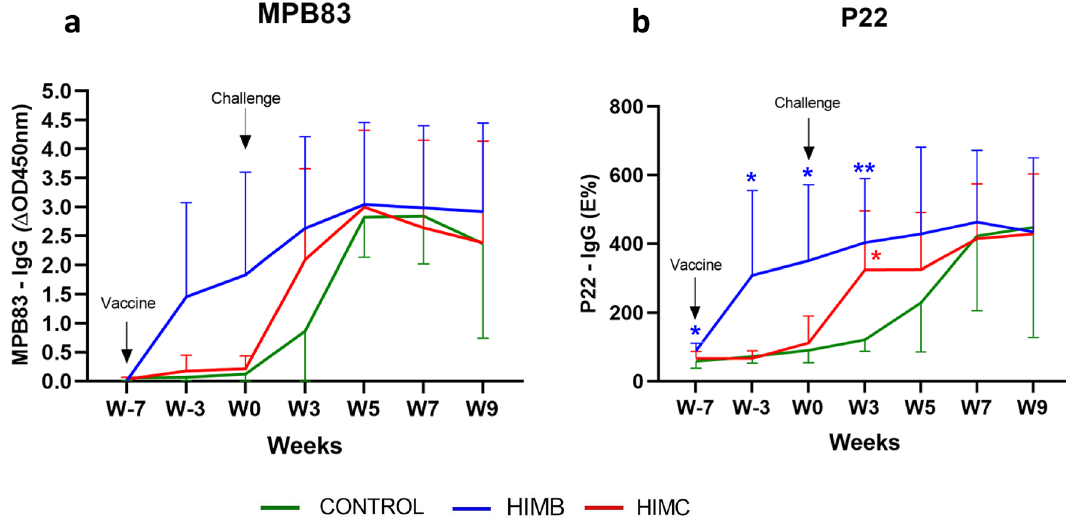
Figure 4. Antibody responses after vaccination and challenge. The figure shows the levels of IgG against MPB83 and P22 antigen measured by ELISA throughout the study. MPB83 results are expressed as the increase of optical density (ΔOD450mn ± 95% CI). P22 ELISA results are expressed as E%: [mean OD450nm of antigen- coated well/(2 × mean negative control OD450nm)] × 100. Groups: Control (N = 7, green, N = 5 at week 9), HIMB (N = 7, blue), HIMC (n = 7, red). * P < 0.05, ** P < 0.01, Kruskal-Wallis test with Dunn’s post hoc test.